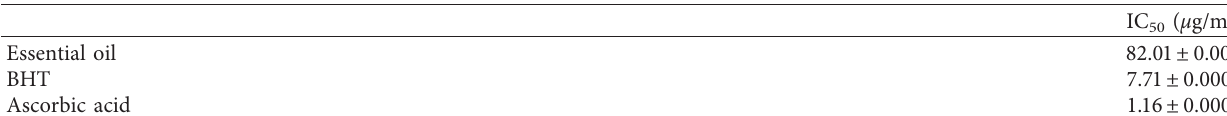
Table 3: IC 50 values of DPPH radical scavenging activity.